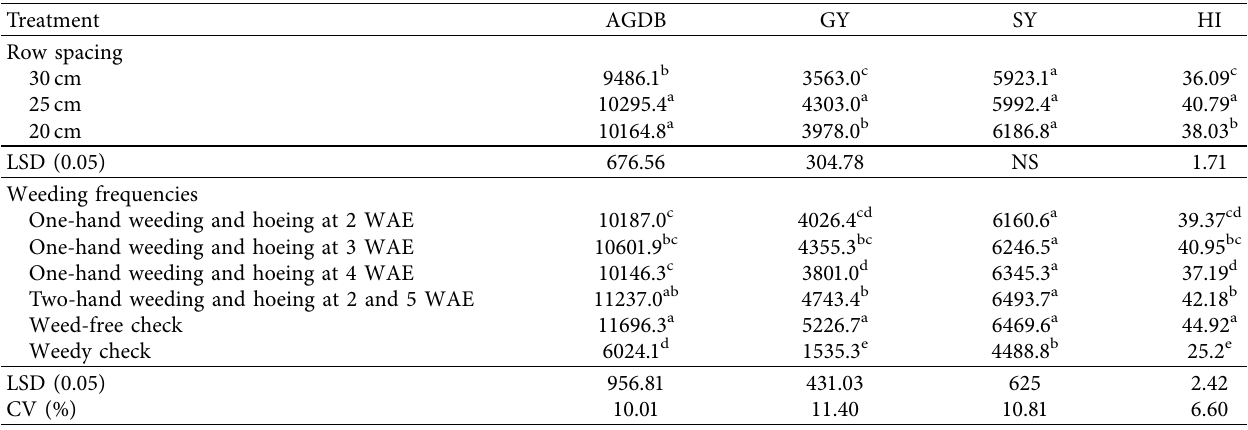
Table 6: Main effect of row spacing and weeding frequencies on yield and yield components of rice at Kuja in 2020 main cropping season.